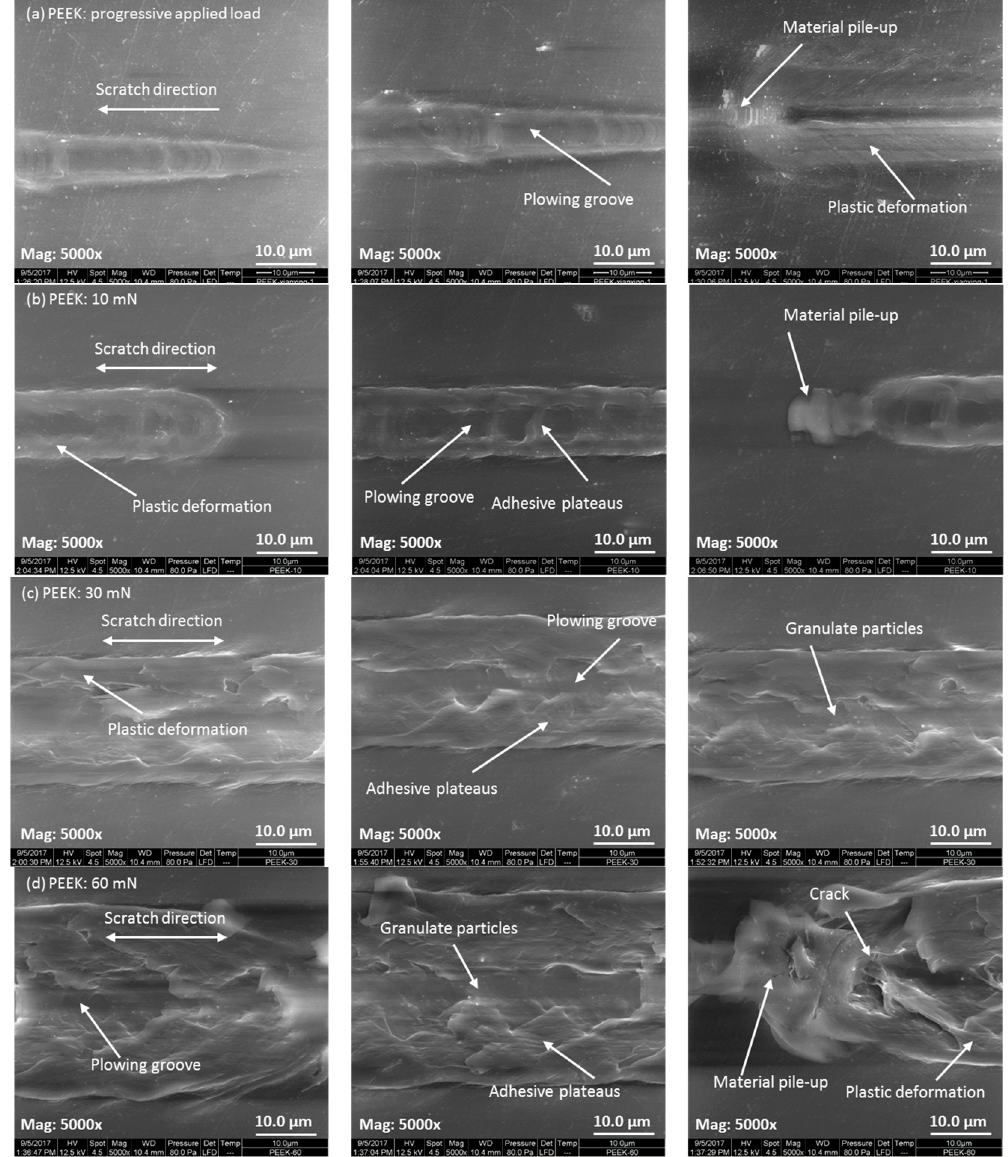
Figure 6. The morphologies of the worn surfaces observed by SEM for PEEK with different applied loads: ( a ) progressive load with an initial load of 0.3 mN and a final load of 60 mN; ( b ) constant load of 10 mN; ( c ) constant load of 30 mN; and ( d ) constant load of 60 mN. The beginning, middle, and end of the wear scar are displayed in the left, middle, and right columns, respectively.